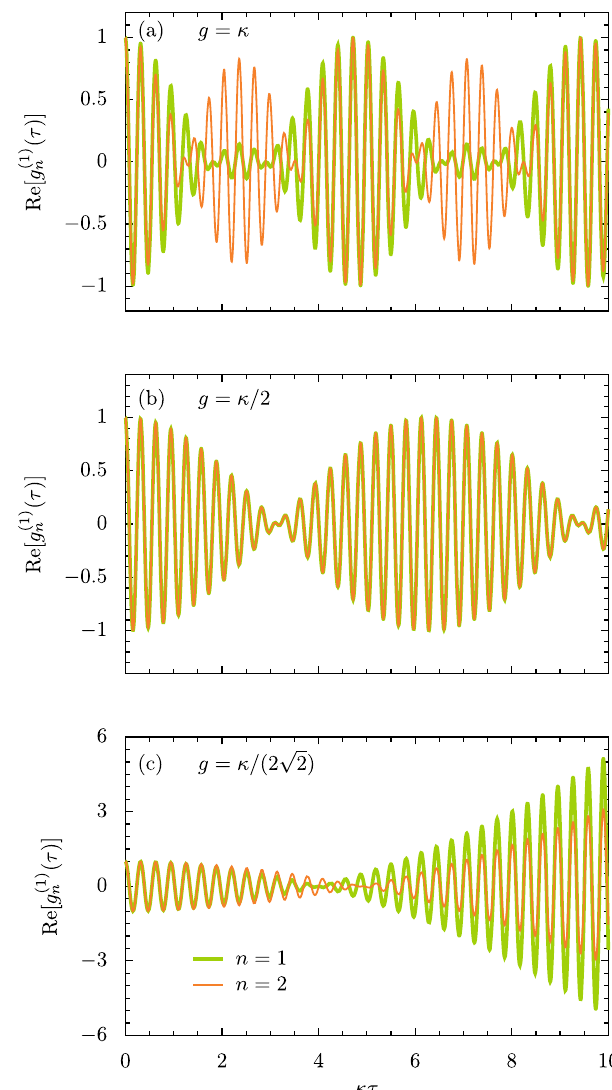
Fig. 3 Dynamics of the correlations. Evolution of the real part of the fi rst- order correlation function g (1) ( τ ), as a function of the time delay τ , in units of the inverse loss-gain parameter κ − 1 [Eq. (24)]. a – c The coupling constant g is reduced from above [ a , b ] to at c the exceptional point located ffiffiffi p at g ¼ κ = ð 2 2 Þ . The results for the fi rst and second oscillators are denoted by the thick green and thin orange lines respectively [see the legend in c , which applies to the whole fi gure]. In the fi gure, ω 0 = 20 κ .